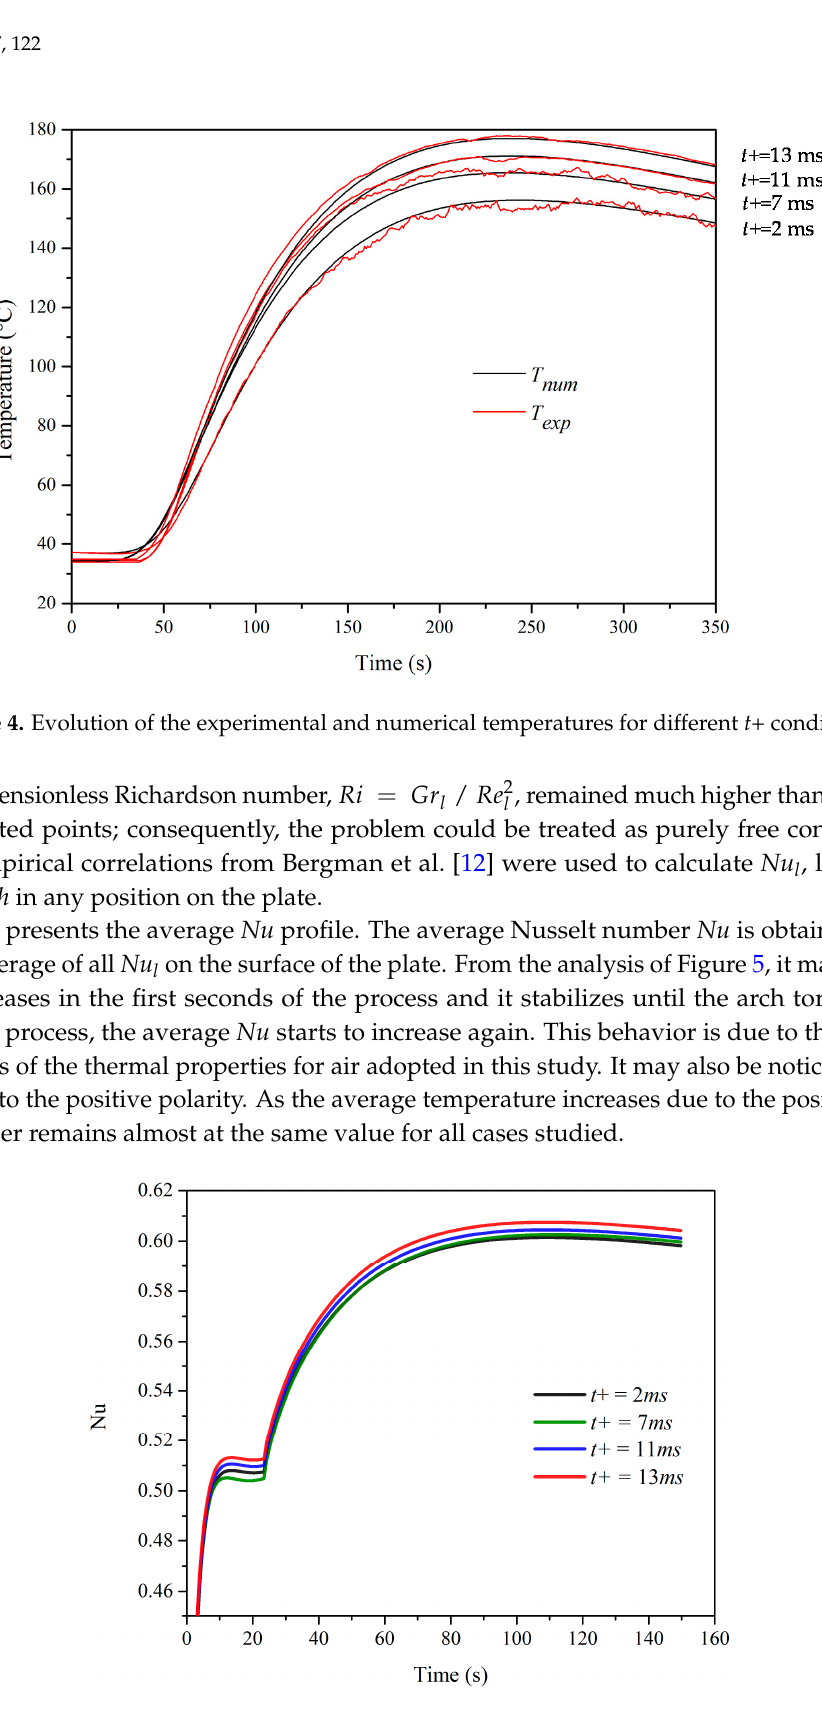
Figure 5. Average Nu on the plate in relation to time.